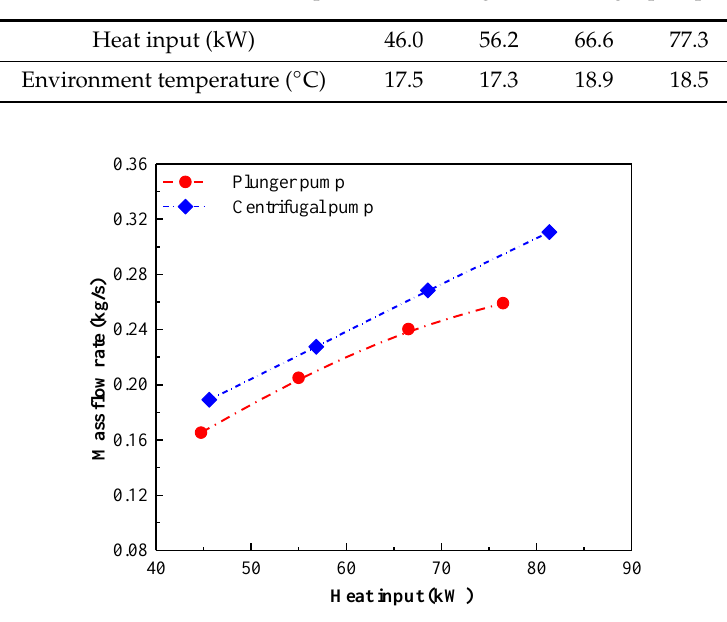
Table 6. The environment temperature for using the centrifugal pump.